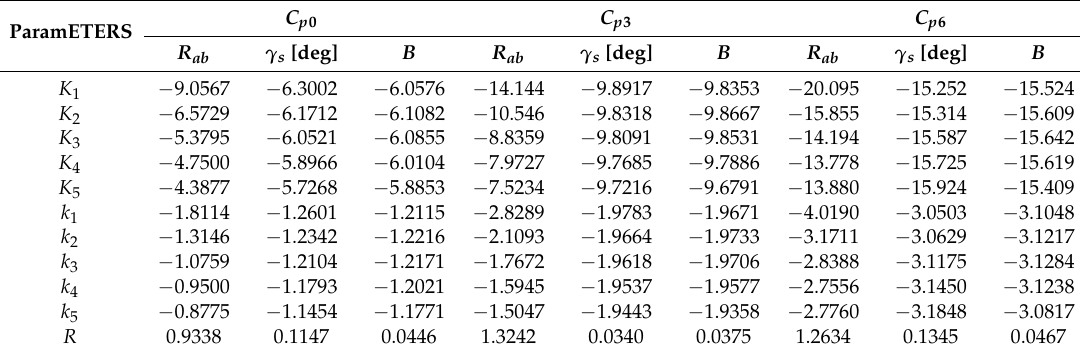
Table 4. Range analysis